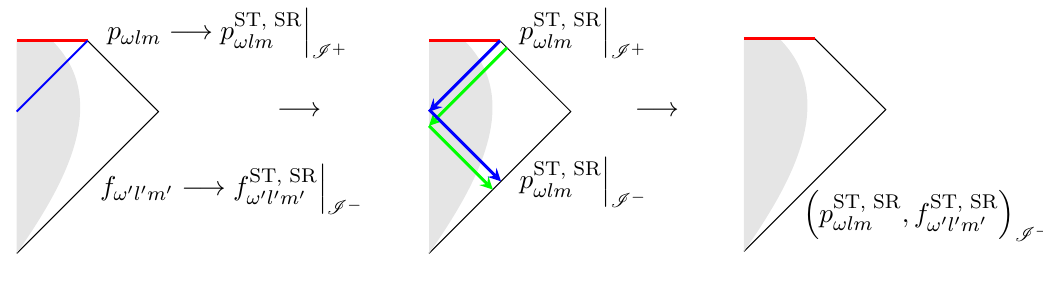
Figure 1 . Diagrammatic picture of the computation performed in this work. From left to right: we (cid:12)rst transform the free-particle states at future and past null in(cid:12)nity by an asymptotic symmetry (supertranslation or superrotation). We then propagate the transformed state at future in(cid:12)nity back to past in(cid:12)nity. Finally, we (cid:12)nd the Hawking spectrum by projecting such state into the transformed state at past null